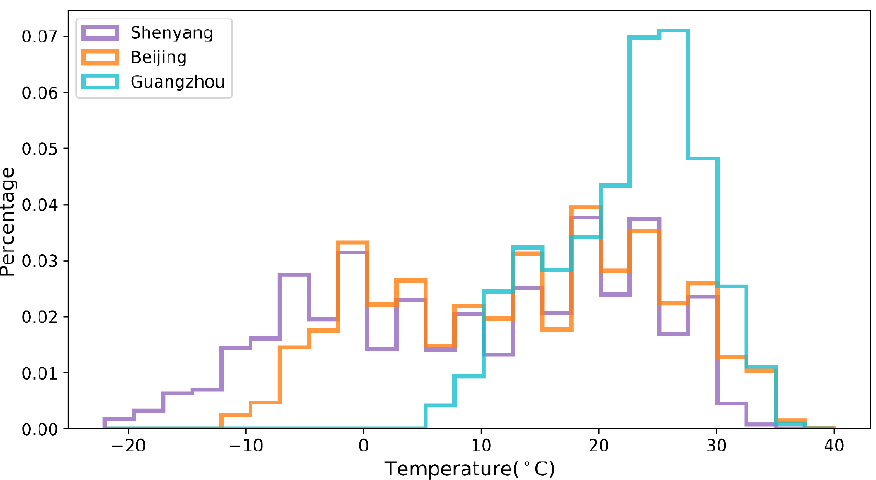
Figure 4. Histograms of the air temperature measurement datasets from three locations, used for model training and validation.